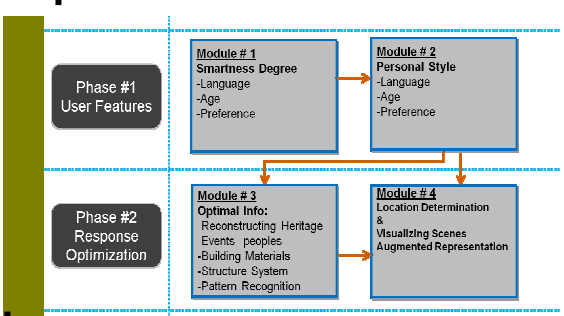
Figure 12. HIPO for the proposed computational system interactive, personalized and contextual-based navigation” with Egyptian heritage